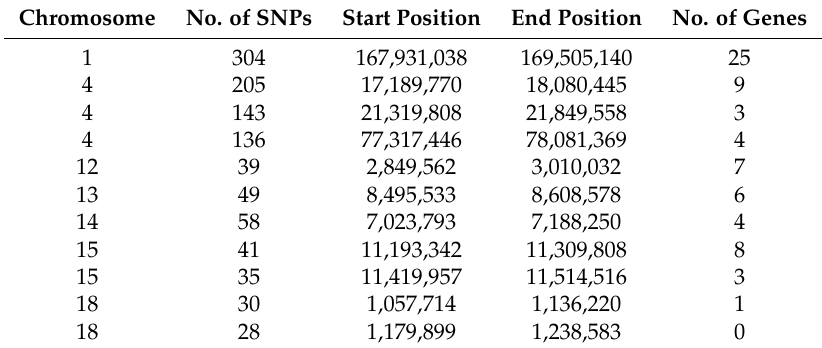
Table 2. Significant peaks as defined in Phase 4 of our analysis framework and corresponding QTLs for